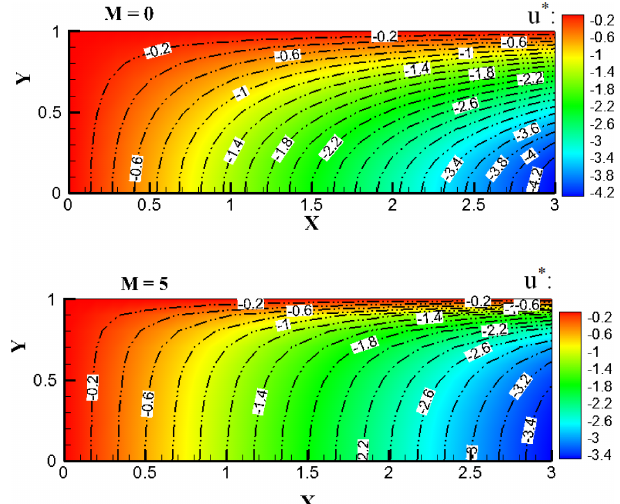
Figure 7. Effects of M Hartman numbers on the velocity contours for De = 0 . 2, Pr = 1, Re w =